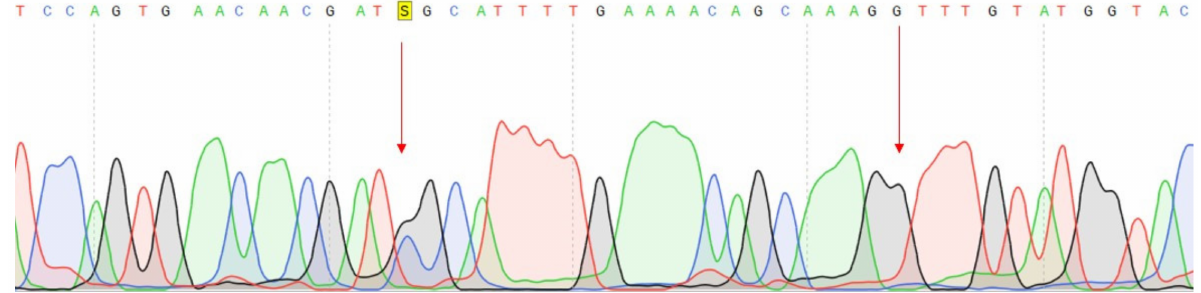
Figure 7. Fragments of the DNA sequence locus in the CDH1 gene (DNA sample with difference in melting